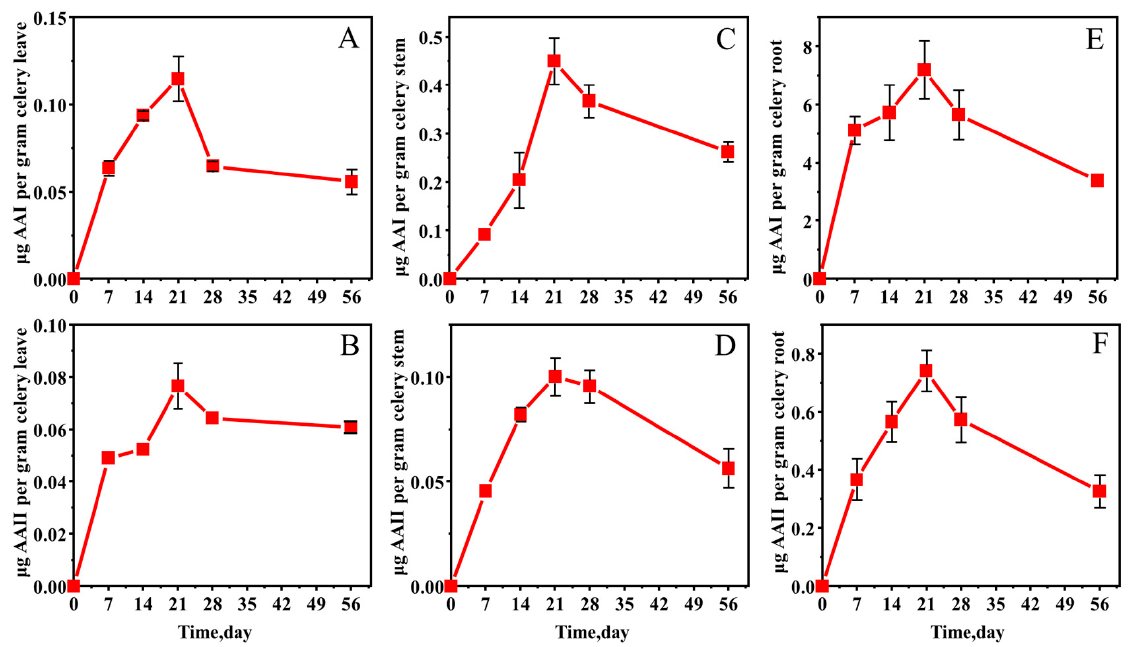
Figure 4. Changes in AA I ( A ) and AA II ( B ) concentrations in celery leaves, AA I ( C ) and AA II ( D ) in stems, and AA I ( E ) and AA II ( F ) in roots grown in AA-contaminated soil. In the tomato samples, roots, stems, leaves, and fruits have the highest absorption rate from 0 to 7 days (Figure 5), which is presumed to be in the tomato growing period. The concentrations of AAs in leaves and fruits reached their peaks on the 21st day. In leaves, the concentration of AA I was 0.494 μ g/g, and AA II was 0.351 μ g/g; in fruits, AA I was 0.270 μ g/g, and AA II was 0.268 μ g/g. With the ripening of fruit leaves, the concen- trations of AAs accumulated in leaves and fruits leveled off from 28 days to 56 days. Fig- ure 5C shows the changes in the AA I content in tomato stems. The concentration of AAs in stems peaked on day 14 at 14.422 μ g/g for AA I and 2.914 μ g/g for AA II, which were much higher than the concentrations in leaves and fruits. After 14 days, the concentrations of AAs in the stems began to decrease. In the roots, sufficient amounts of AAs had been absorbed after 7 days, and the concentrations were significantly higher compared with those in lettuce and celery, with an AA I concentration of 87.764 μ g/g and an AA II con- centration of 10.322 μ g/g. The patterns of changes in the AA II content in the leaves, fruits, stems, and roots of tomatoes were consistent with the changes in AA I (Figure S2). By comparing celery and lettuce, we can find that tomatoes absorb the most AAs. It can be presumed that tomatoes require more nutrients when they bear fruit and absorb them faster from the soil, and the plants are larger and require more soil. Therefore, AAs are accumulated more in plants that are actively growing, flowering, and fruiting, and the more AAs that are present in the soil, the more they are accumulated. In addition, a num- ber of factors played a role in the results, such as the daily watering quantity and the nutrient requirements of different plants at different growth stages.